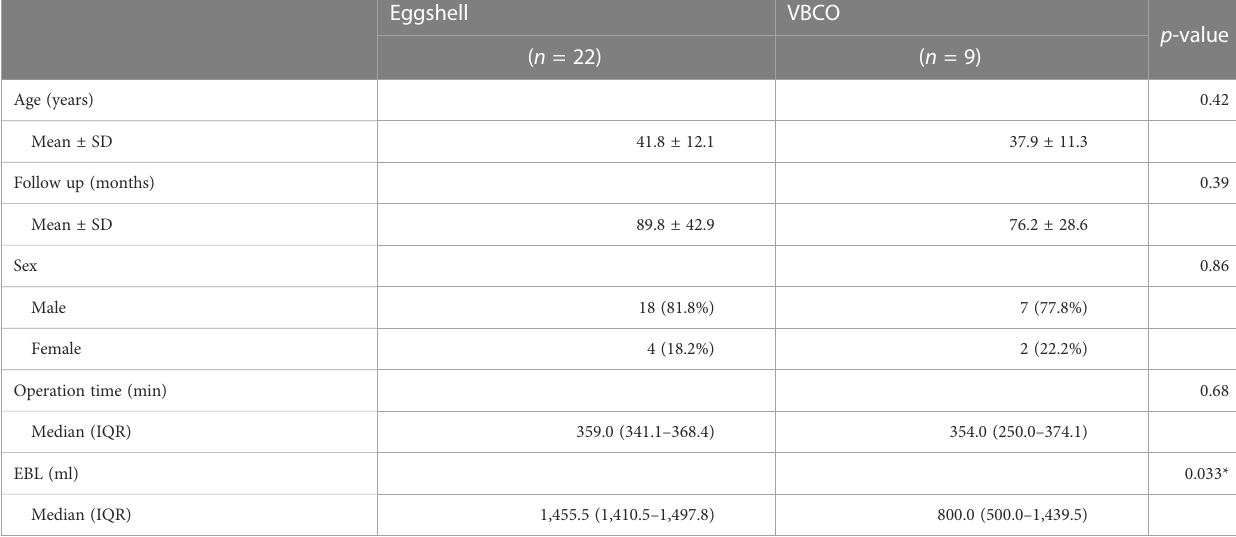
TABLE 4 Demographic and surgical information of patients.